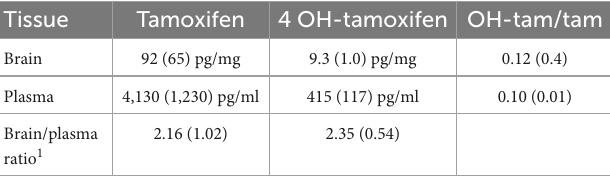
TABLE 1 Tamoxifen and 4-OH-tamoxifen measures. Tissue